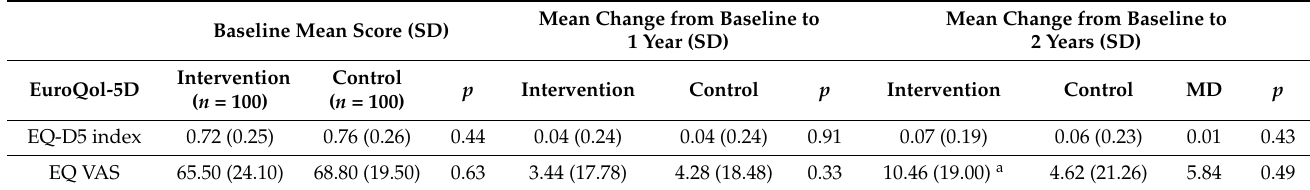
Table 3. Health-related quality-of-life endpoint at baseline and 1 and 2